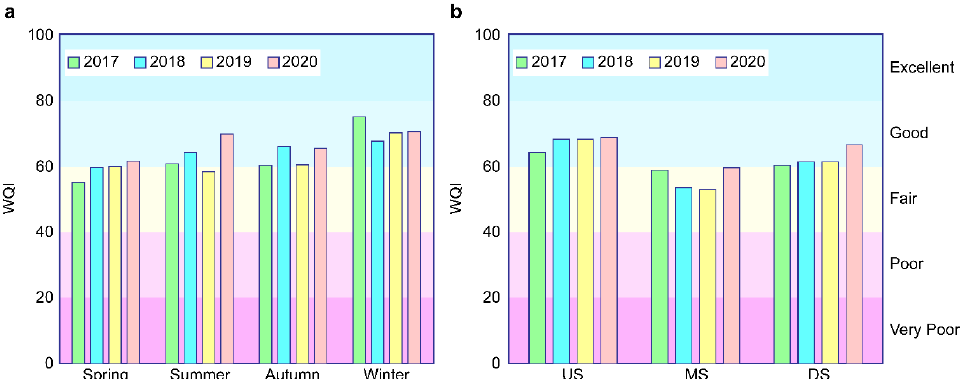
Figure 8. Seasonal and spatial WQI scores. Four bar graphs in each seasonal or spatial group show WQI scores from 2017 to 2020 from the left to right. The letters on the right represent the water quality grades of the WQI. Excellent, Suitable for hydrophilic activities with clean water; Good, Suitable for hydrophilic activities with good water; Fair, sometimes pollutants may be introduced and affect hydrophilic activity; Poor, Attention of hydrophilic activities due to frequent inflow of pollutants; Very poor, Inadequate for hydrophilic activities with a high water pollution level. WQI, water quality index; ( a ), seasonal WQI; ( b ), spatial WQI.